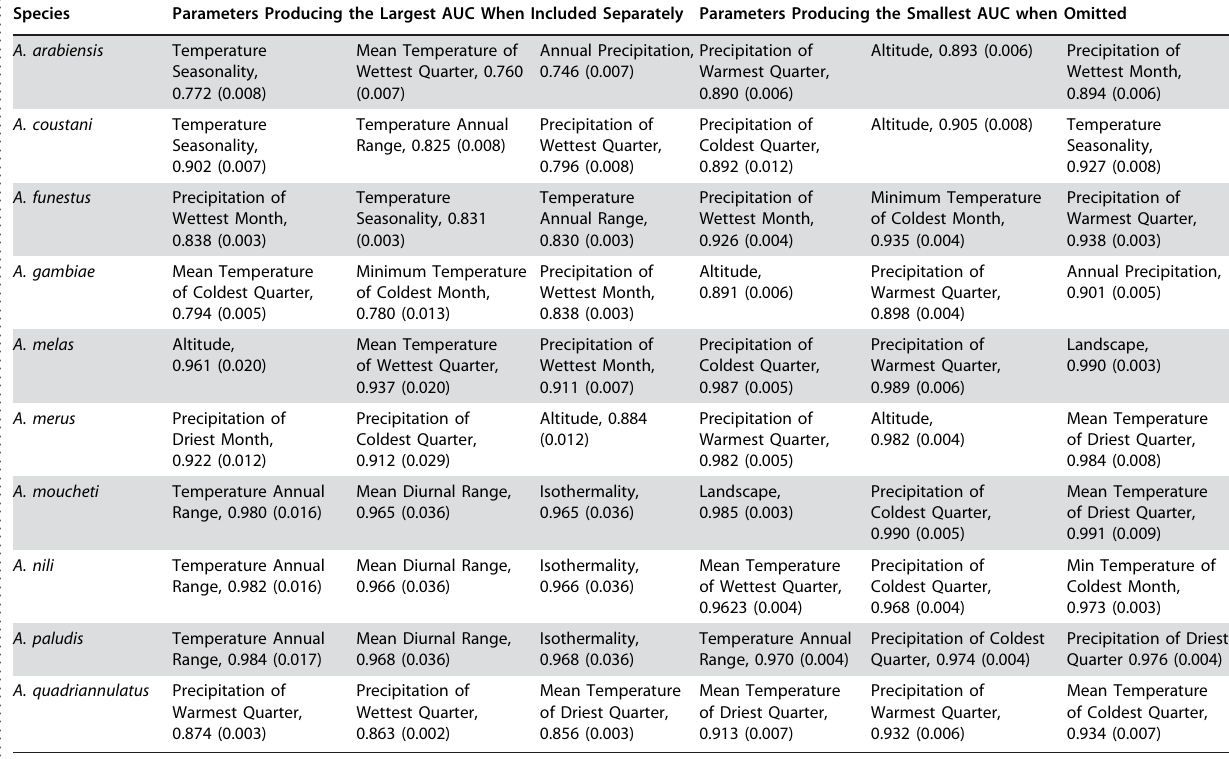
Column (i) lists the 10 Anopheles species for which niche models were constructed. Columns (ii–iv) list the three parameters that produced the largest AUC when taken individually. These parameters are listed in decreasing order from (ii) to (iv) on the basis of their associated AUC values. Thus column (ii) lists the environmental parameter that possesses the most information regarding the niche of each species. Columns (v–vii) list the three parameters that produced the smallest AUC when omitted. These parameters are listed in increasing order from (ii) to (iv) on the basis of their associated AUC values. Thus column (v) lists the environmental parameter that possesses the most information not possessed by the other parameters regarding the niche of each species. Average AUC values are provided next to each environmental parameter with the standard deviation of the values provided in